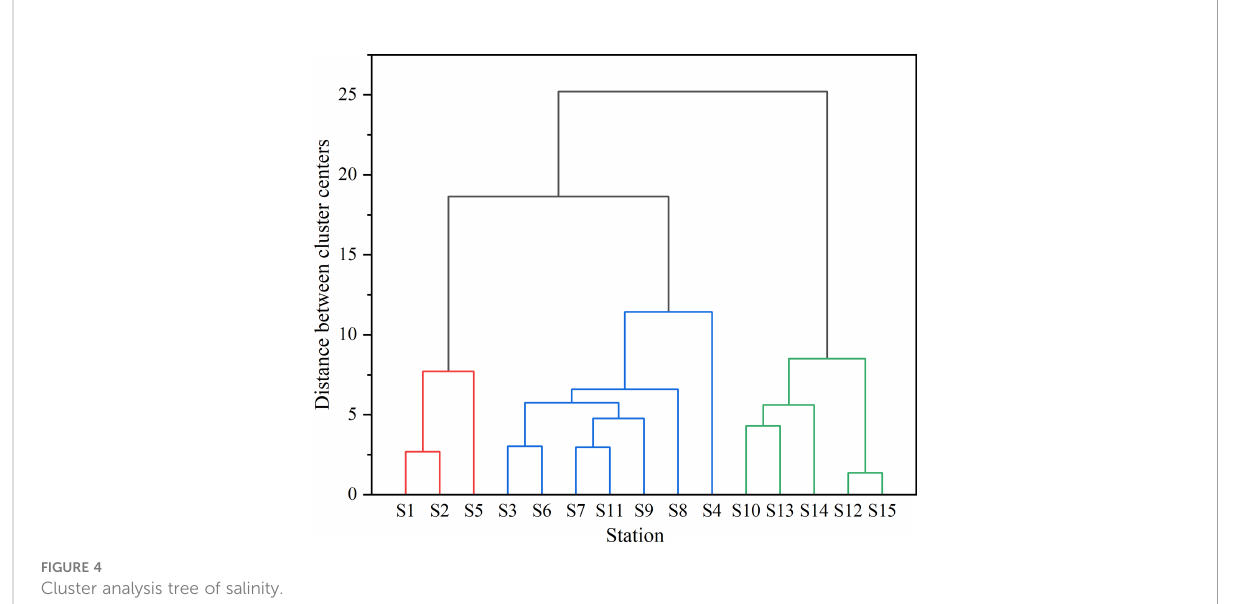
FIGURE 4 Cluster analysis tree of